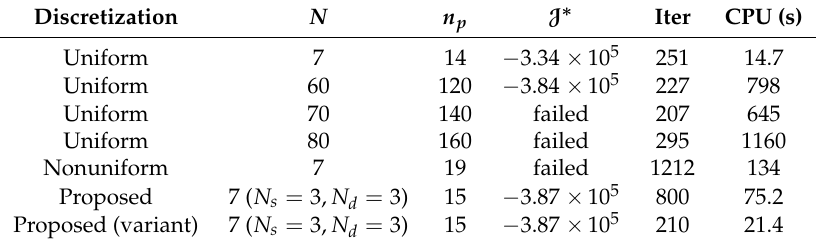
Table 3. Optimal objective values, number of iterations, and CPU times for different discretization strategies in Problem (40). n p denotes the total number of optimization variables for each